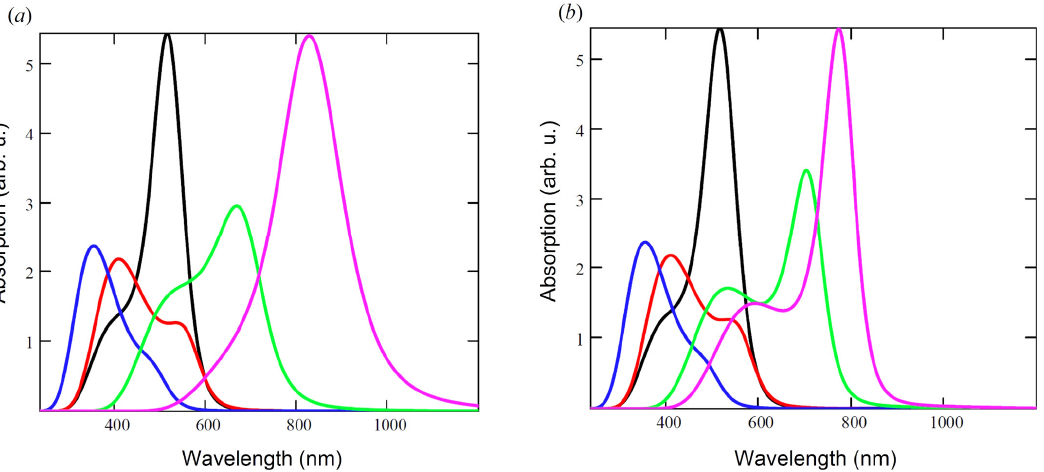
Figure 16. The same as in Figure 15, except for the wavelengths on the abscissa axis [1]. Mathcad